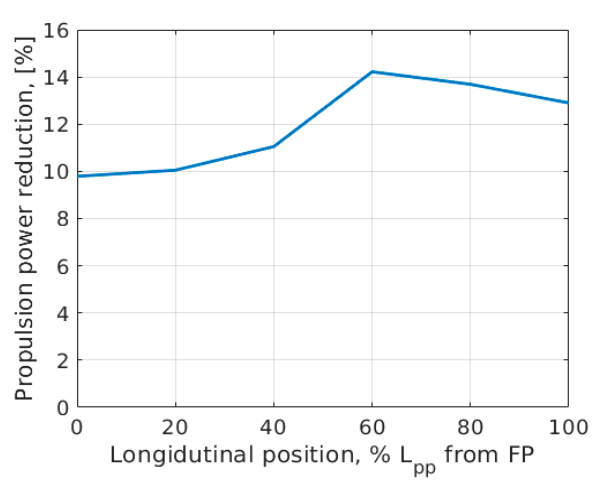
Figure 7. Influence of the longitudinal position on the power savings.